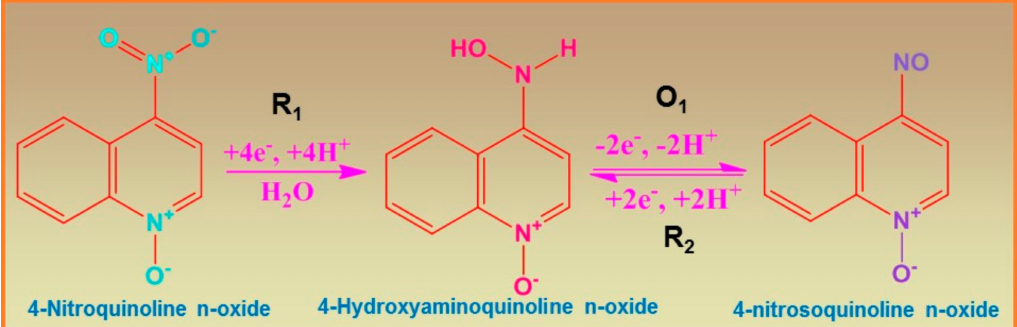
Figure 6. Possible reduction mechanism of 4-NQO at NiCo 2 S 4 -Ms /